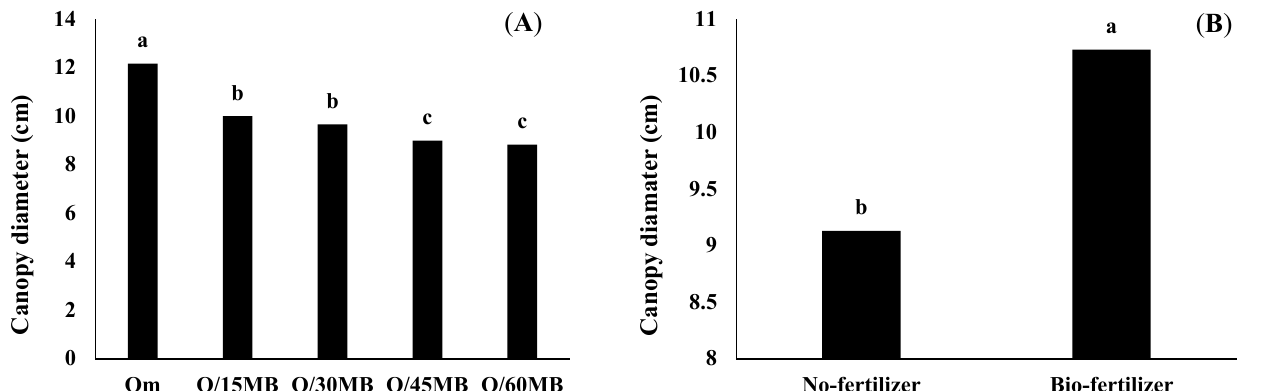
Figure 2. The main effect of cropping patterns ( A ) and fertilizer application ( B ) on the canopy diameter of marjoram. Om: marjoram monocropping; O/15MB: intercropping ratios of 100% marjoram + 15% mung bean; O/30MB: 100% marjoram + 30% mung bean; O/45MB: 100% marjoram + 45% mung bean; O/60MB: 100% marjoram+ 60% mung bean. Different lower-case letters above the bars indicate significant ( p ≤ 0.05) differences.